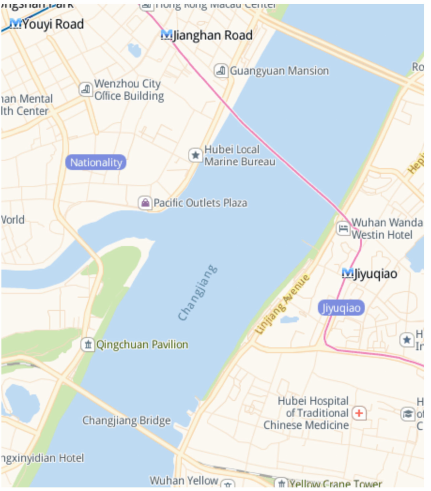
Figure 9. Schematic diagram of experimental data acquisition